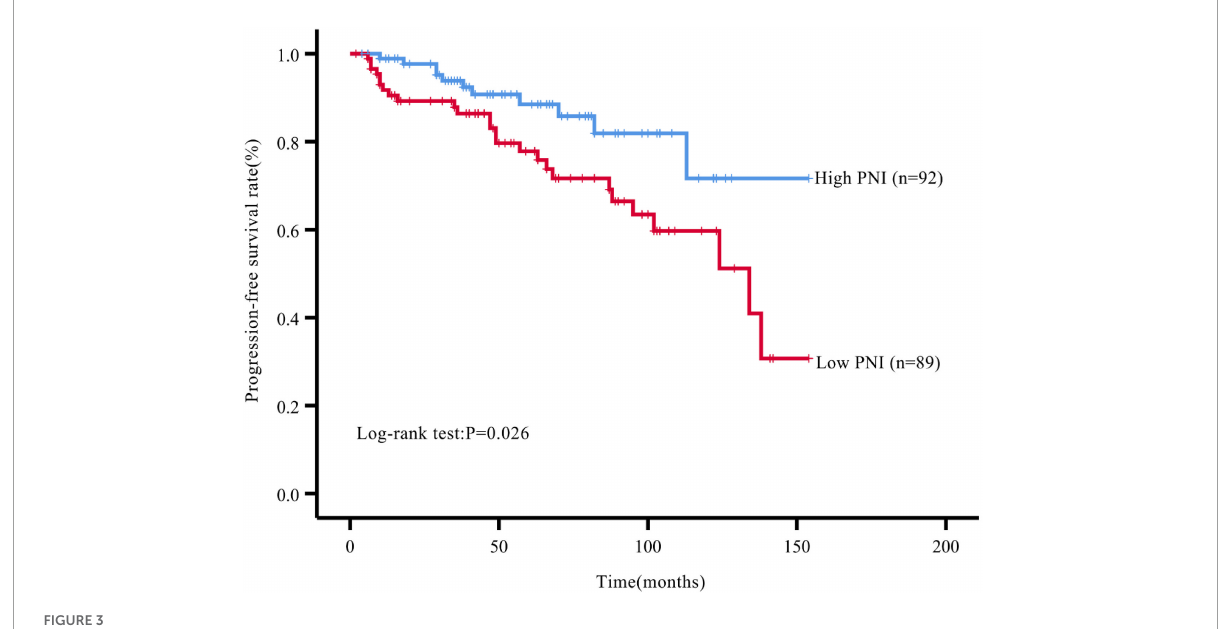
FIGURE3 Kaplan–Meier survival curve analysis of PFS rate grouped by PNI levels.